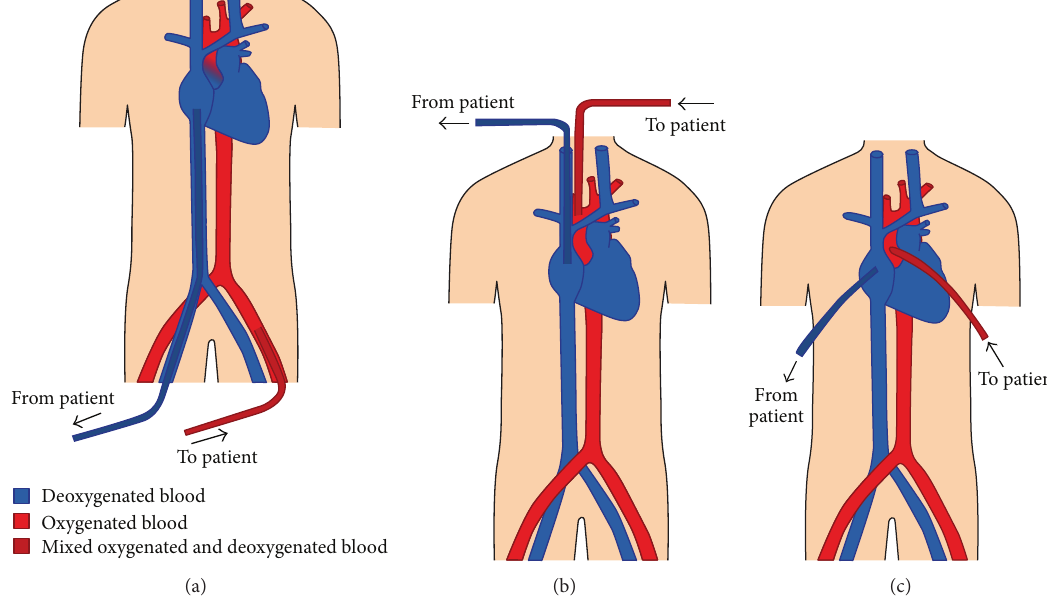
Figure 2: Illustrations of various VA ECMO cannulations. Diagram (a) depicts a femoral vein-femoral artery peripheral cannulation. Retrograde outflow from a femoral arterial cannula competes with anterograde cardiac output ejected from the left ventricle. In this situation, poor lung function results in the ejection of deoxygenated blood (blue) from the left ventricle, which mixes with oxygenated blood (red) from theECMOcircuit.Thepointofmixing(darkred)islocatedatthebaseoftheaorticroot,butwillvarydependingonthepatient’sheartfunction and ECMO flow. Poor lung function and good myocardial function in the context of a femoral-femoral ECMO cannulation may result in upper body hypoxemia (see text). Diagram (c) shows central cannulation with venous inflow drawn from the right atrium and arterial outflow pumped into the ascending aorta.